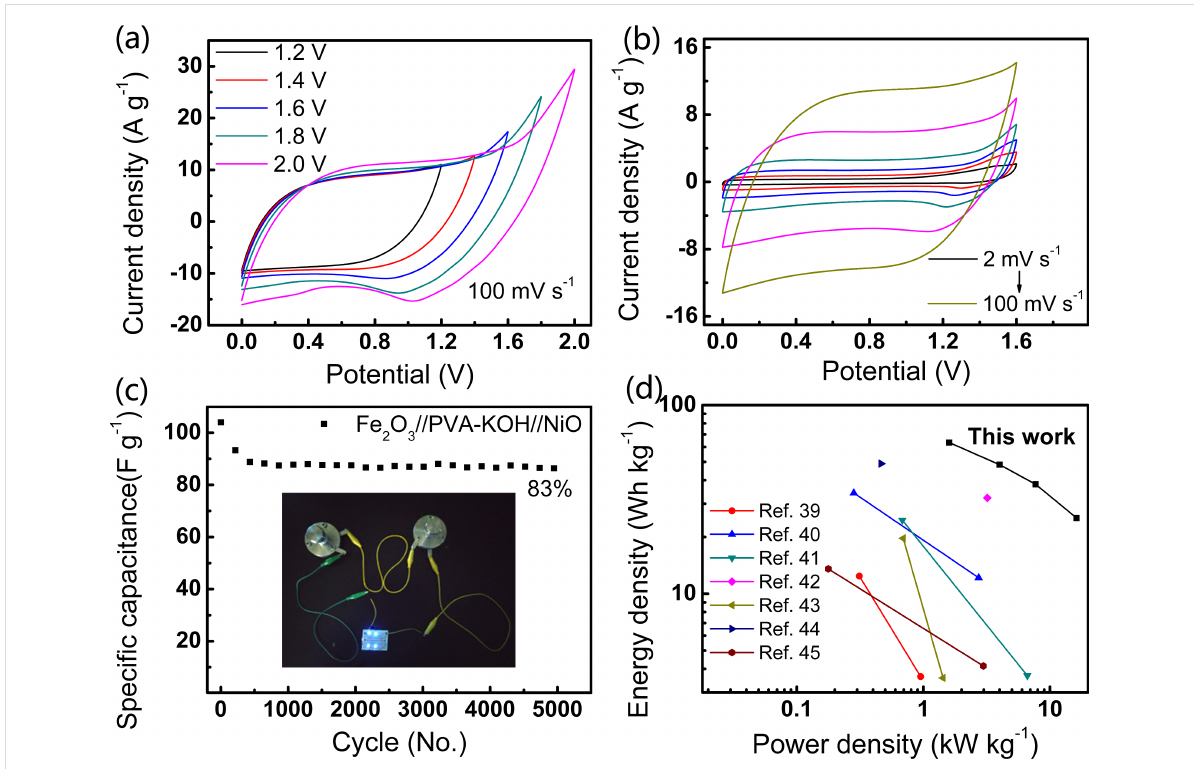
Figure 8: (a) CV curves of the all-solid-state ASC recorded at voltage windows from 1.2 to 2.0 V. (b) CV curves of the device performed at scan rates from 2 to 100 mV·s − 1 at 1.6 V. (c) Cycling test of the device with 83% retention after 5000 cycles. The insert shows the demo of two devices in series which can power four blue LEDs. (d) Ragone plot of the device compared with previously reported results